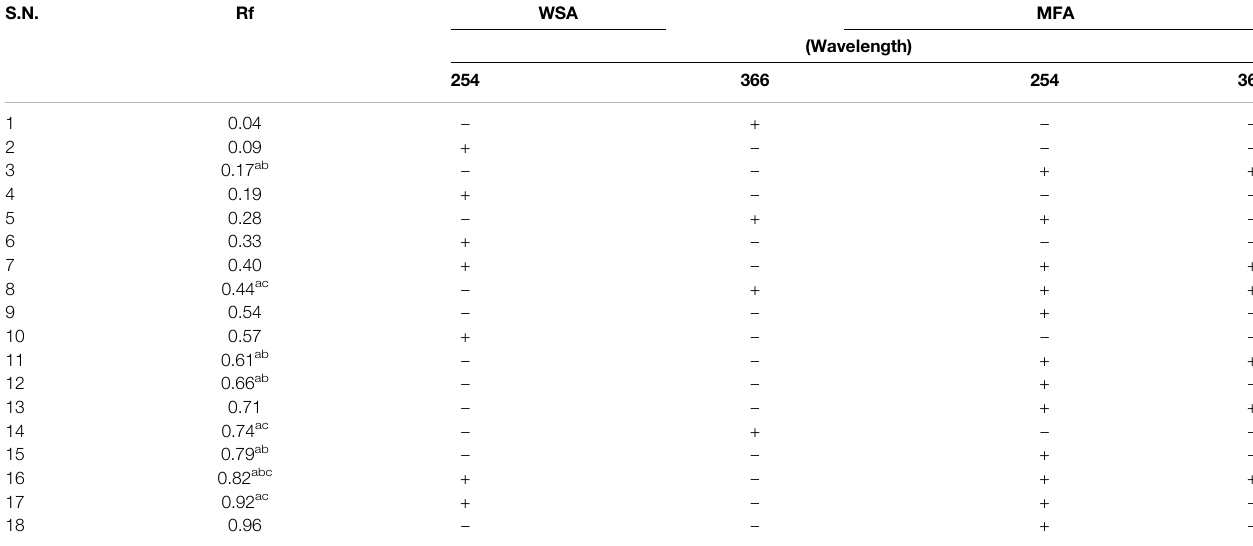
TABLE 3 | TLC pro fi ling of WSA and MFA separated in toluene: ethyl acetate: acetic acid (7:2:1, v/v/v) at 254 and 366 nm. S.N. Rf WSA